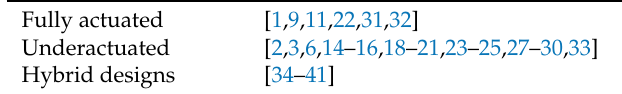
Table 2. Related work—Robotic hands mechanical structure review.